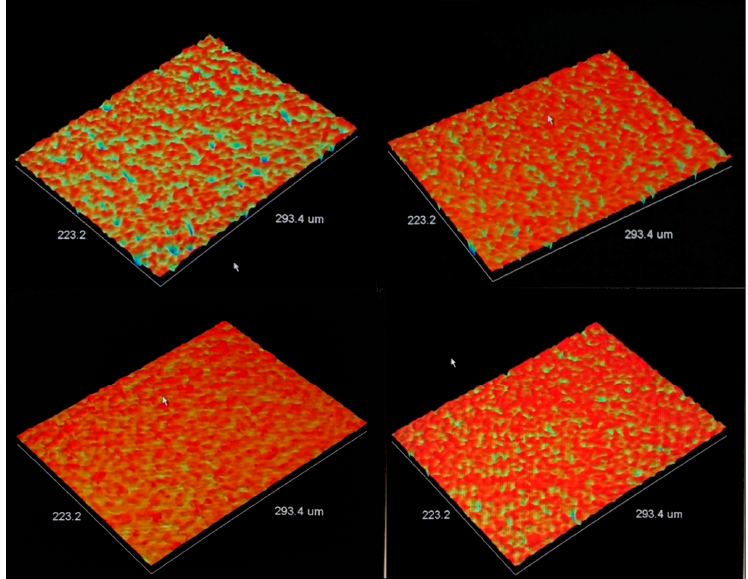
Figure 3. Investigation of the surface roughness of NiO photocathodes implementing a blocking layer electrochemically deposited at 1.00 V (top left), 1.05 V (top right), 1.10 V (bottom left) or deposited by Sol-Gel (bottom right).